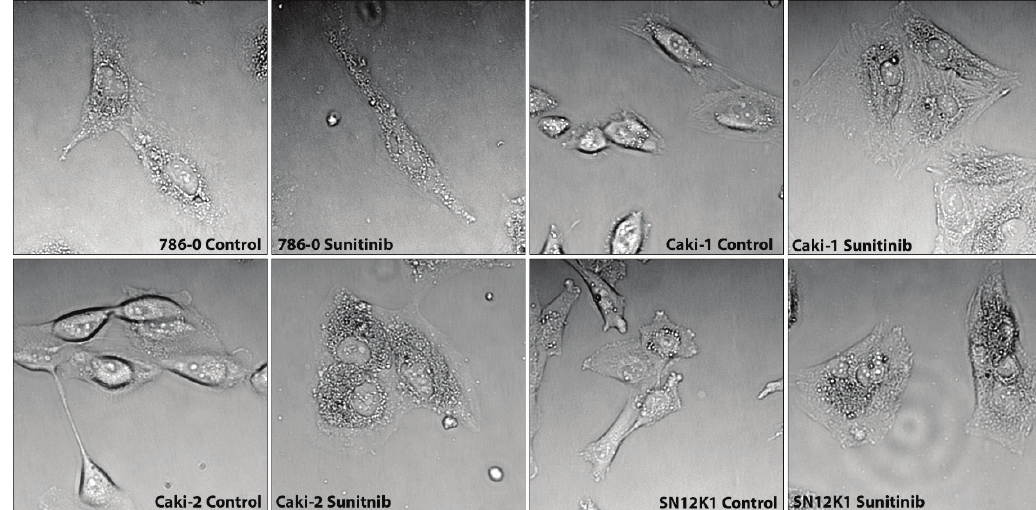
Figure 3. Phase contrast microscopy of live cells showing hypertrophy of sunitinib-resistant cells. Representative phase contrast microscopy further confirms the hypertrophic nature of sunitinib-resistant